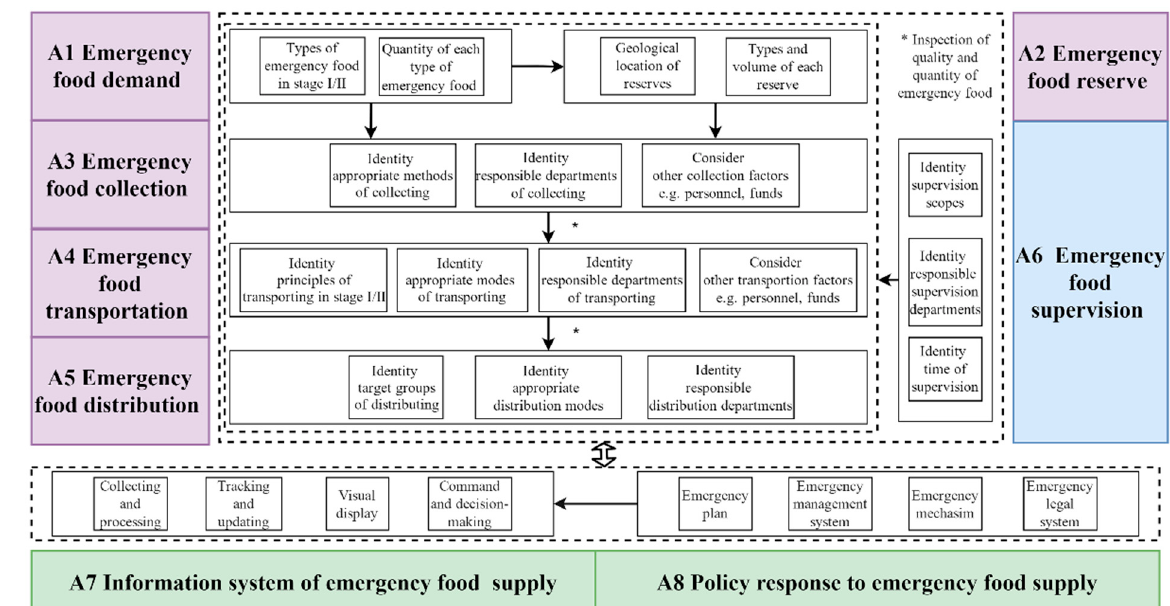
Figure 2. The emergency food supply